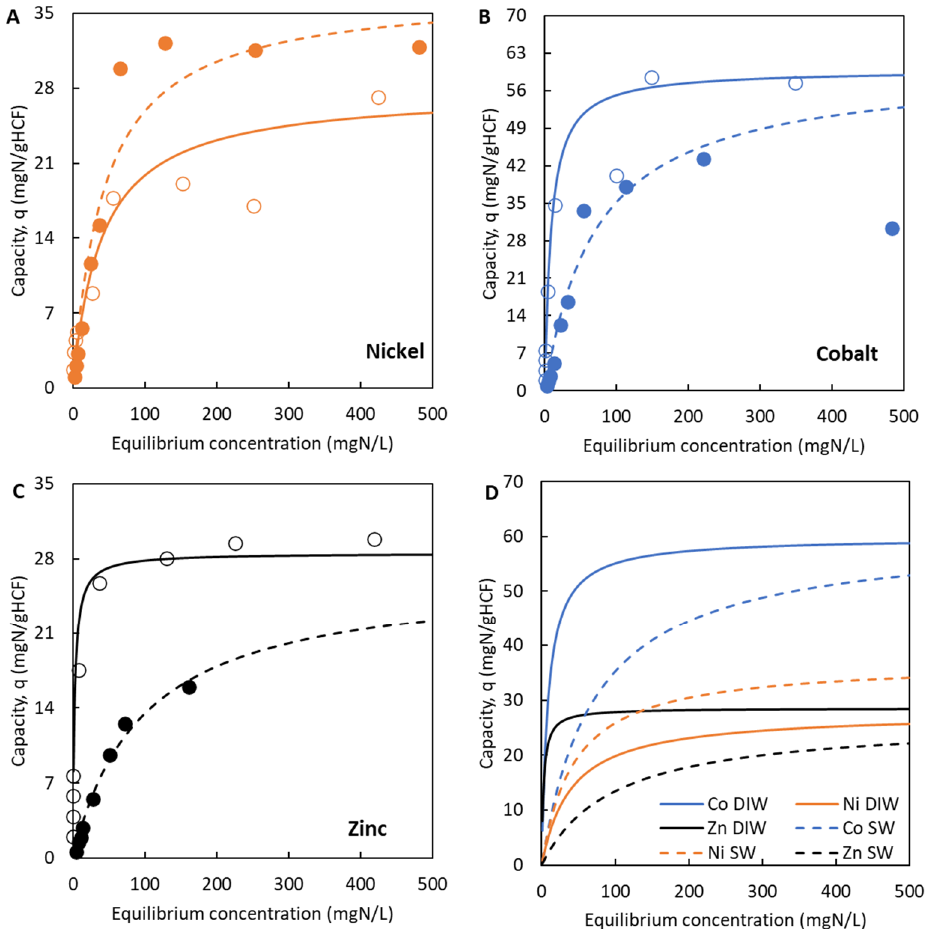
Figure 3. Isotherms performed on the three chosen MeHCFs. Dots indicate empirical results (empty circle—DIW, filled circle—SW); lines indicate the Langmuir model simulation (solid line—DIW, dashed line-SW). ( A ) NiHCF; ( B ) CoHCF; ( C ) ZnHCF; and ( D ) showing only the Langmuir model regression of all Me-HCFs (Dashed lines—SW, solid lines—DIW). Temperature = 25 ± 1 °C, n = 3.